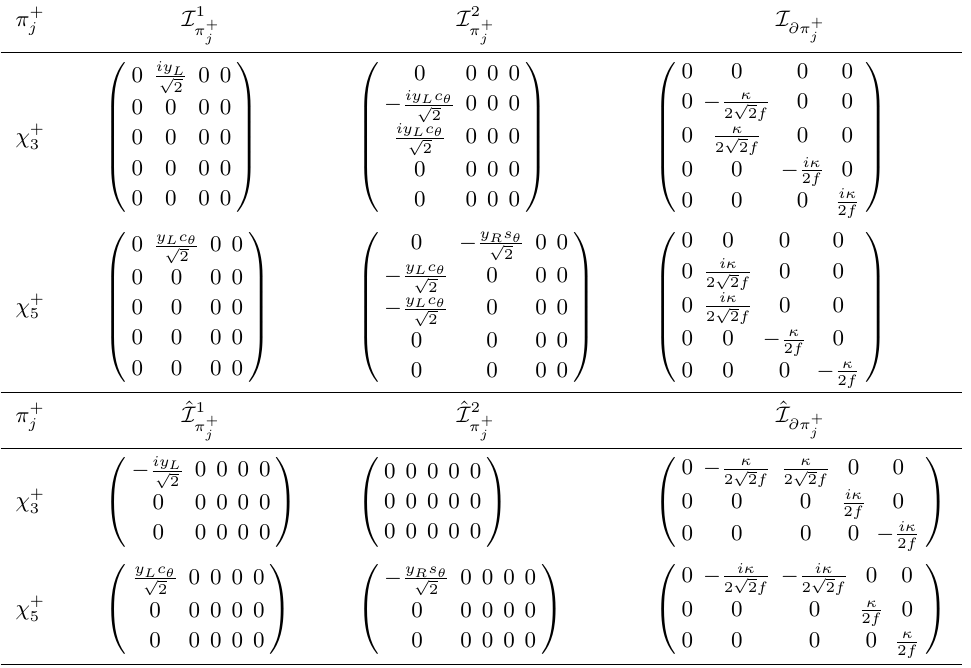
, ˆ I 1 , 2 , I and ˆ I where ∂π + ∂π + π + π + j j j j